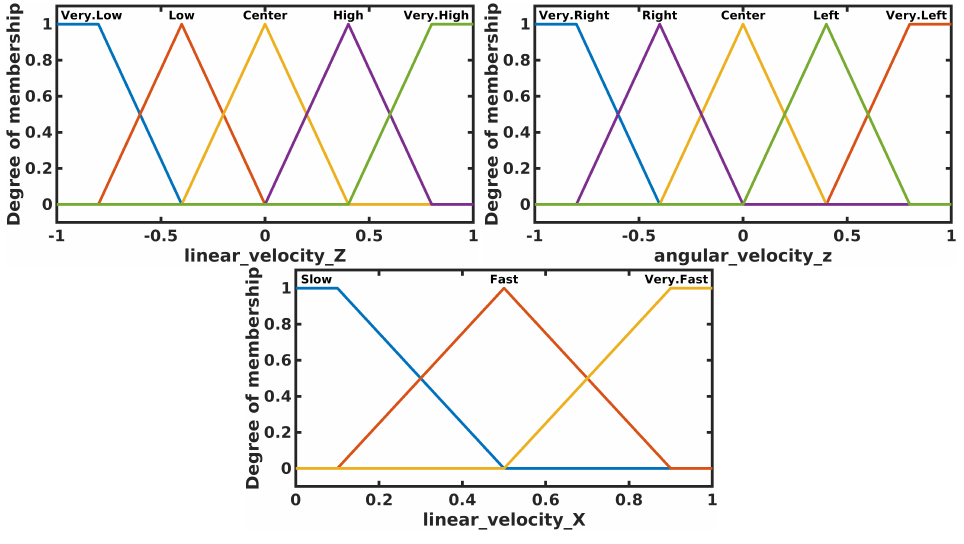
Figure 12. Output fuzzification.